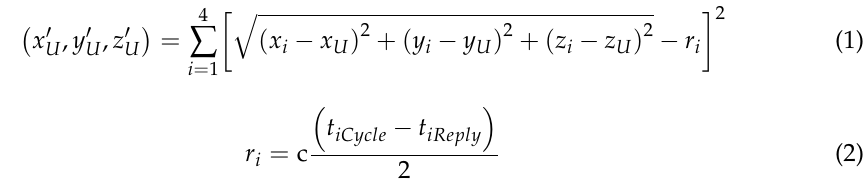
Figure 4. Wearable IoT device. ( a ) Placement of UWB and IMU module at right shoe; ( b ) circuit diagram of custom board.